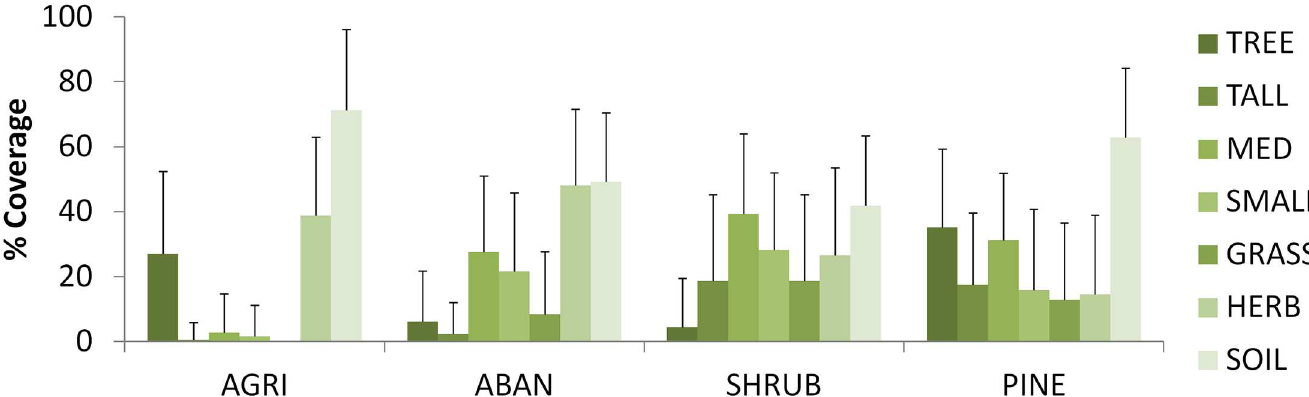
Fig 3. Mean cover of each environmental variable significant in the DFA per patch. Pine forest (PINE), natural shrubs (NAT), drylandtree-based crop fields (AGRI) and abandoned crop fields (ABAND). See Table 1 for categories of vegetationcover (TREE, TALL, etc.). AGRI = 216, ABAND = 155, NAT = 158 and PINE = 127